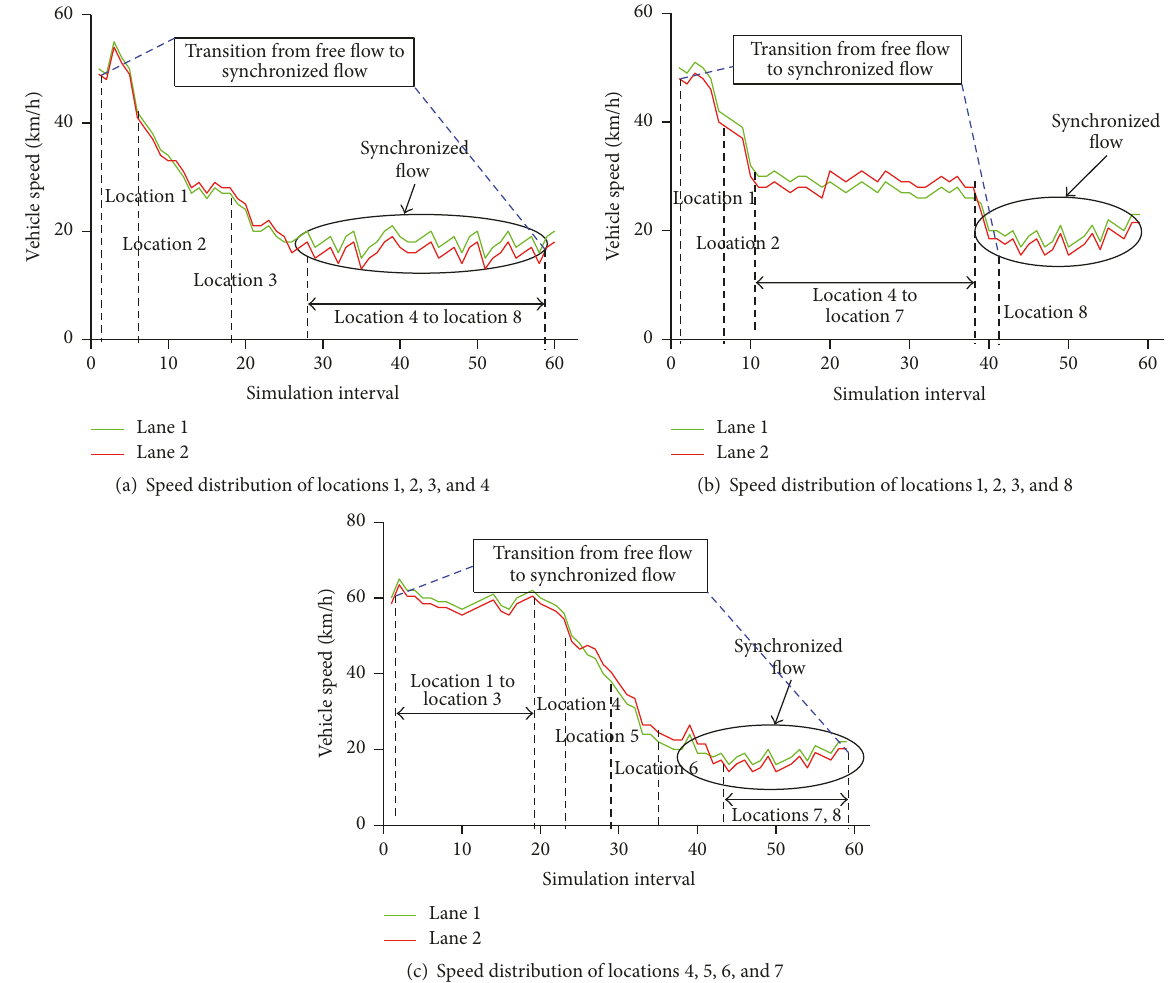
Figure 12: Speed distribution of different